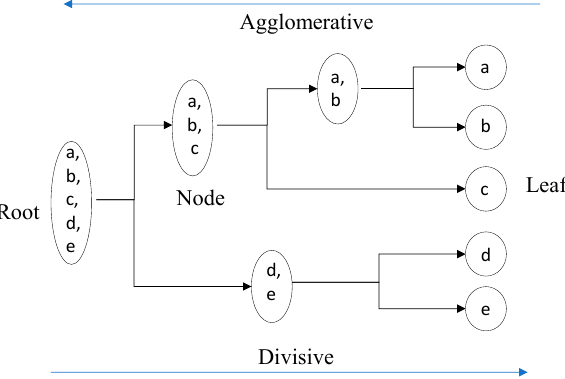
Figure 3. An example dendrogram for hierarchical clustering algorithms [27].